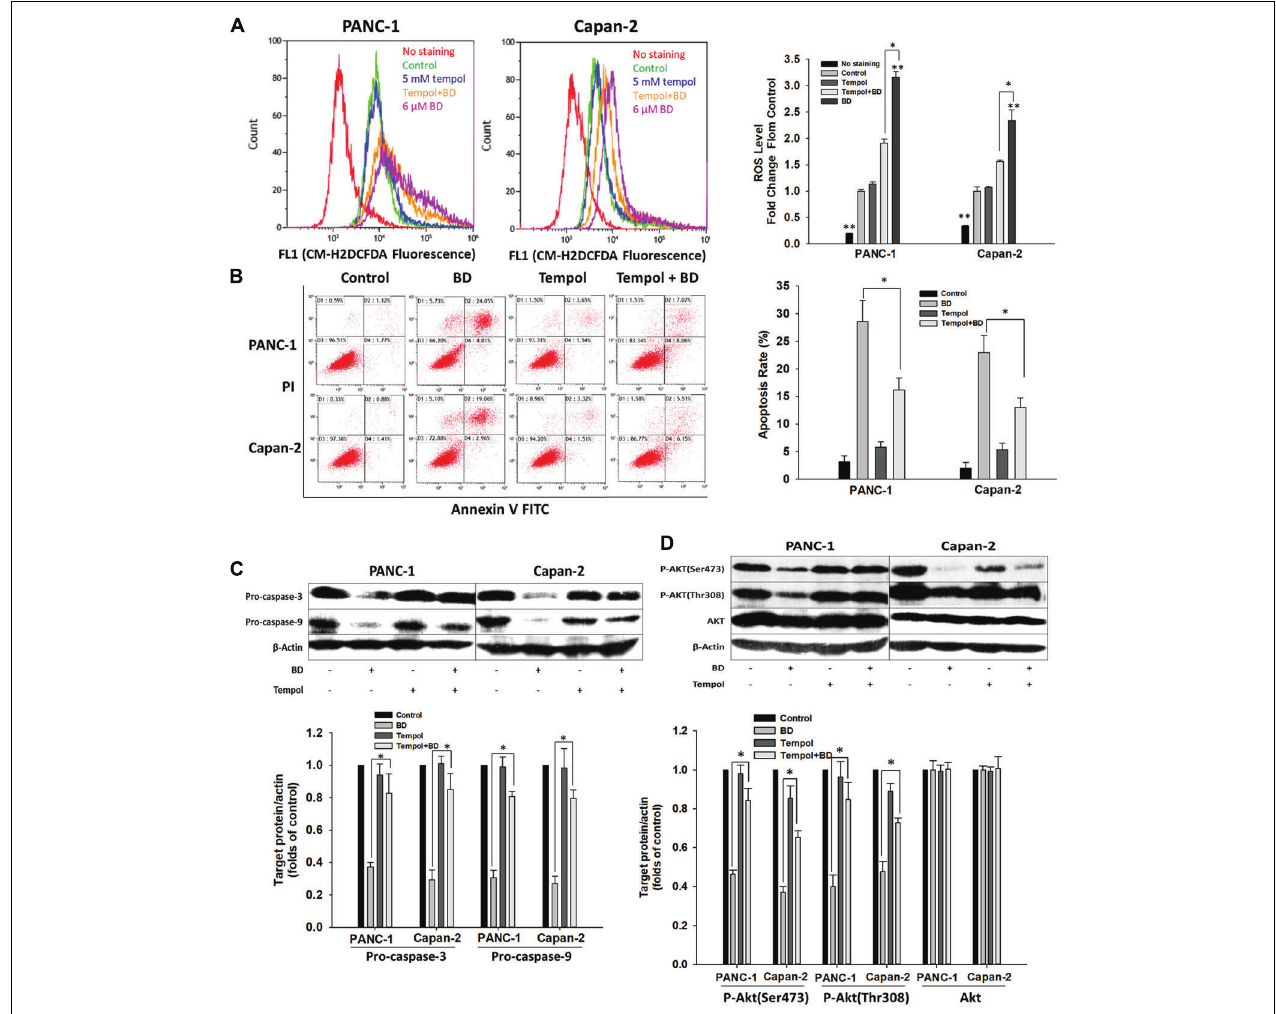
FIGURE 5 | Brucein D-mediated apoptosis involves ROS generation. (A) Representative flow cytometry histograms showing the relative content of ROS after pretreatment with tempol (5 mM) for 2 h, followed by 12 µ M BD treatment for 24 h. Data are expressed as fold changes in CM-H2DCFDA fluorescent levels of the treated cells to the non-treated cells (Control). (B) Flow cytometric analysis was carried out by Annexin V-FITC and PI double-staining after pretreatment with tempol (5 mM) for 2 h, followed by 12 µ M BD treatment for 48 h. (C) Protein lysates of the cells either pretreated with 5 mM tempol for 2 h or left alone followed by BD treatment for 24 h were analyzed by Western blotting. β -Actin served as the loading control. (D) Cells were either pretreated with 5 mM tempol for 2 h or left alone followed by BD treatment for 24 h. The expression of Akt and p-Akt was analyzed by Western blotting. β -Actin served as the loading control. Each bar represents means ± SD of three separate experiments. ∗ P < 0.05 and ∗∗ P < 0.01 vs the control